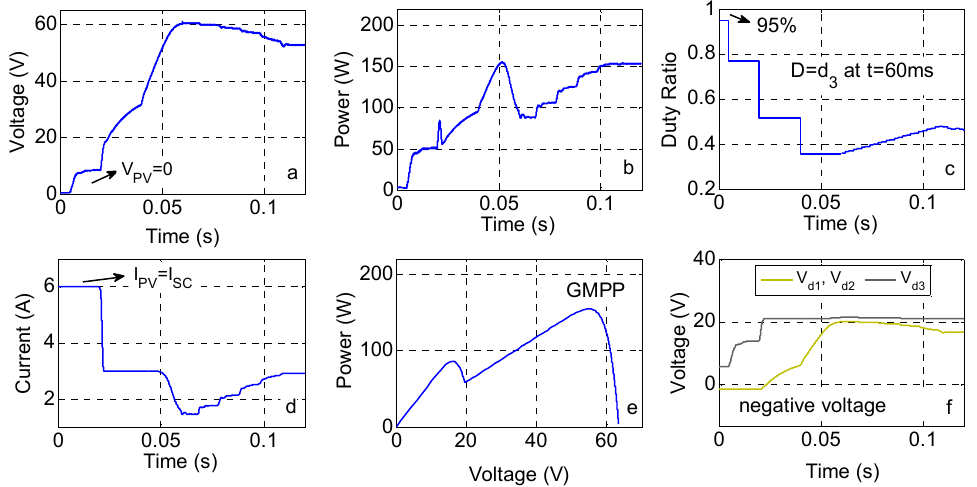
Figure 11. Case 2 ( a ) Voltage; ( b ) Power; ( c ) Duty Ratio; ( d ) Current; ( e ) P-V curve; and, ( f ) Voltage of bypass diode.